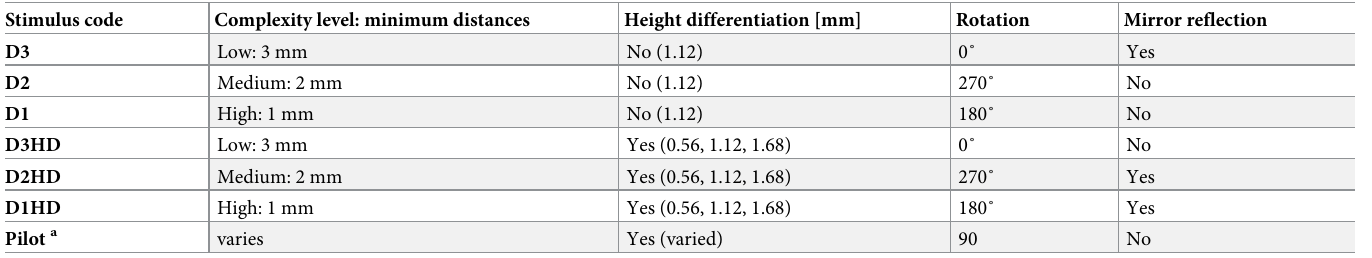
Table 1. Tactile stimuli